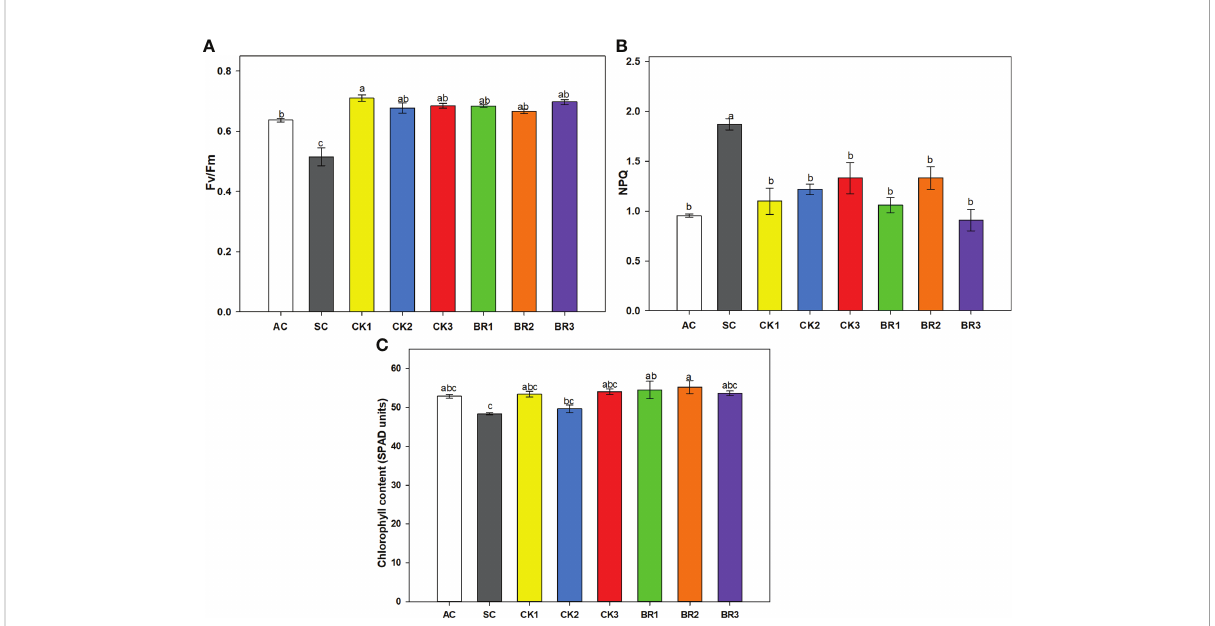
FIGURE 2 Effect of the number of sprays of two growth regulators (cytokinins (CK) or brassinosteroids (BR)) on the ratio of variable to maximum chlorophyll fl uorescence from photosystem II (F v /F m ) (A) , non-photochemical quenching (NPQ) (B) , and chlorophyll content (C) in rice plants of genotype Fedearroz 2000 subjected to combined heat stress (40°C day/30°C night) at 55 days after emergence (DAE). The treatments evaluated were as follows: absolute control (AC), heat stress control (SC), one foliar spray of CK (CK1), two foliar sprays of CK (CK2), three foliar sprays of CK (CK3), one foliar spray of BR (BR1), two foliar sprays of BR (BR2) or three foliar sprays of BR (BR3). Each column represents the mean of fi ve data ± standard error (n = 5). Bars followed by different letters indicate statistically signi fi cant differences according to Tukey ’ s test (P ≤ 0.05). Equal letters indicate that the means are not statistically signi fi cant ( ≤